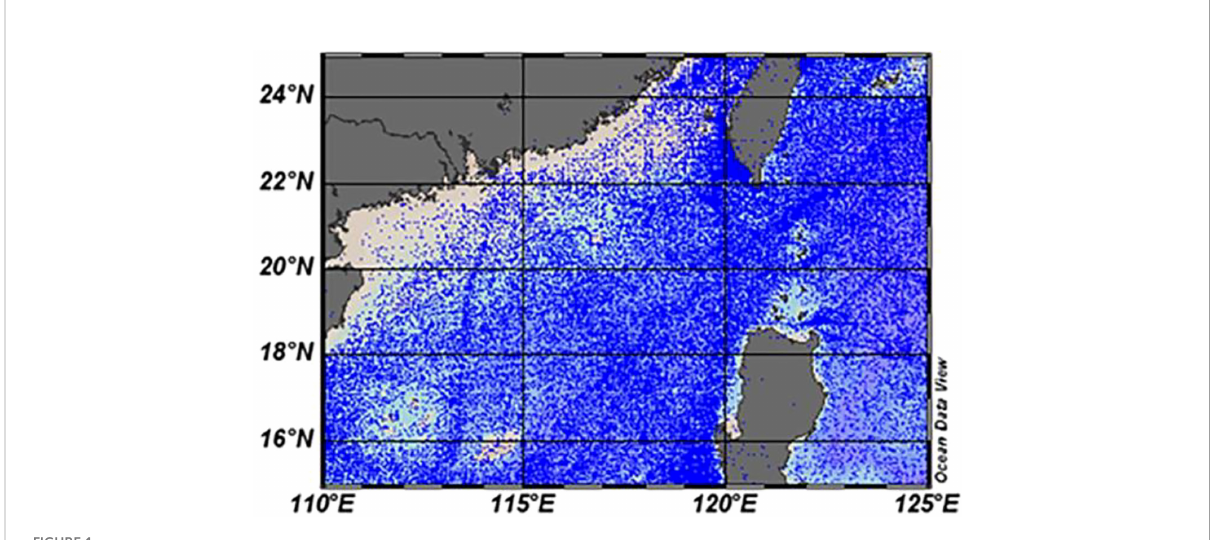
FIGURE 1 Distribution of observed T – S pro fi le stations in the northern South China